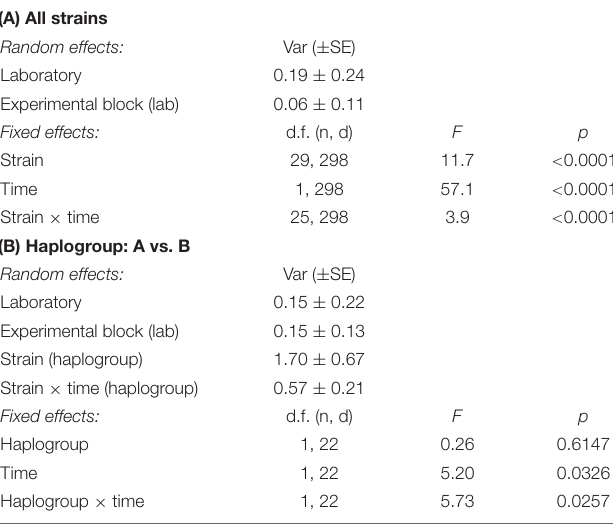
TABLE 2 | ANOVA results from GLMM models of resistance of Paramecium caudatum to Holospora undulata , as a function of strain identity, time (early vs. late measurements) and haplogroup (A vs. B).